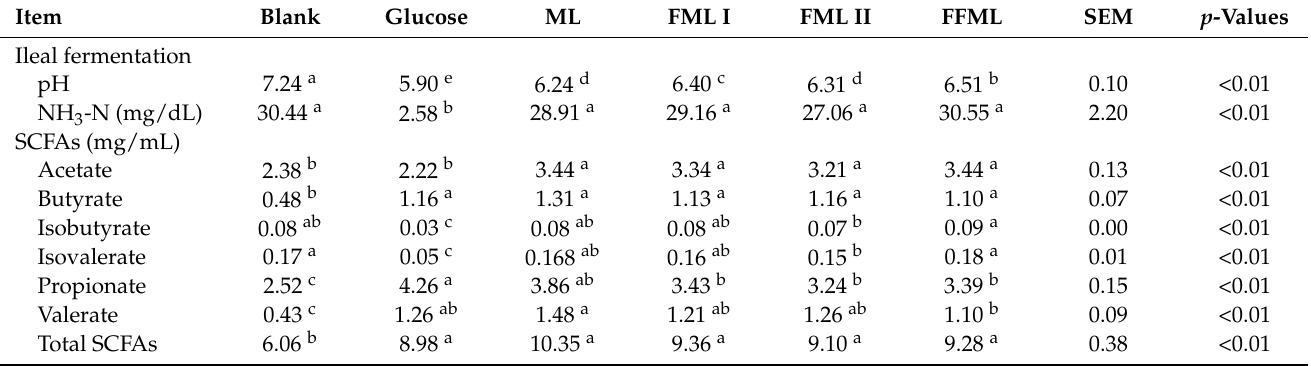
Table 6. In vitro fermentation parameters of Mao-tai lees and fermented Mao-tai lees in the ileum and